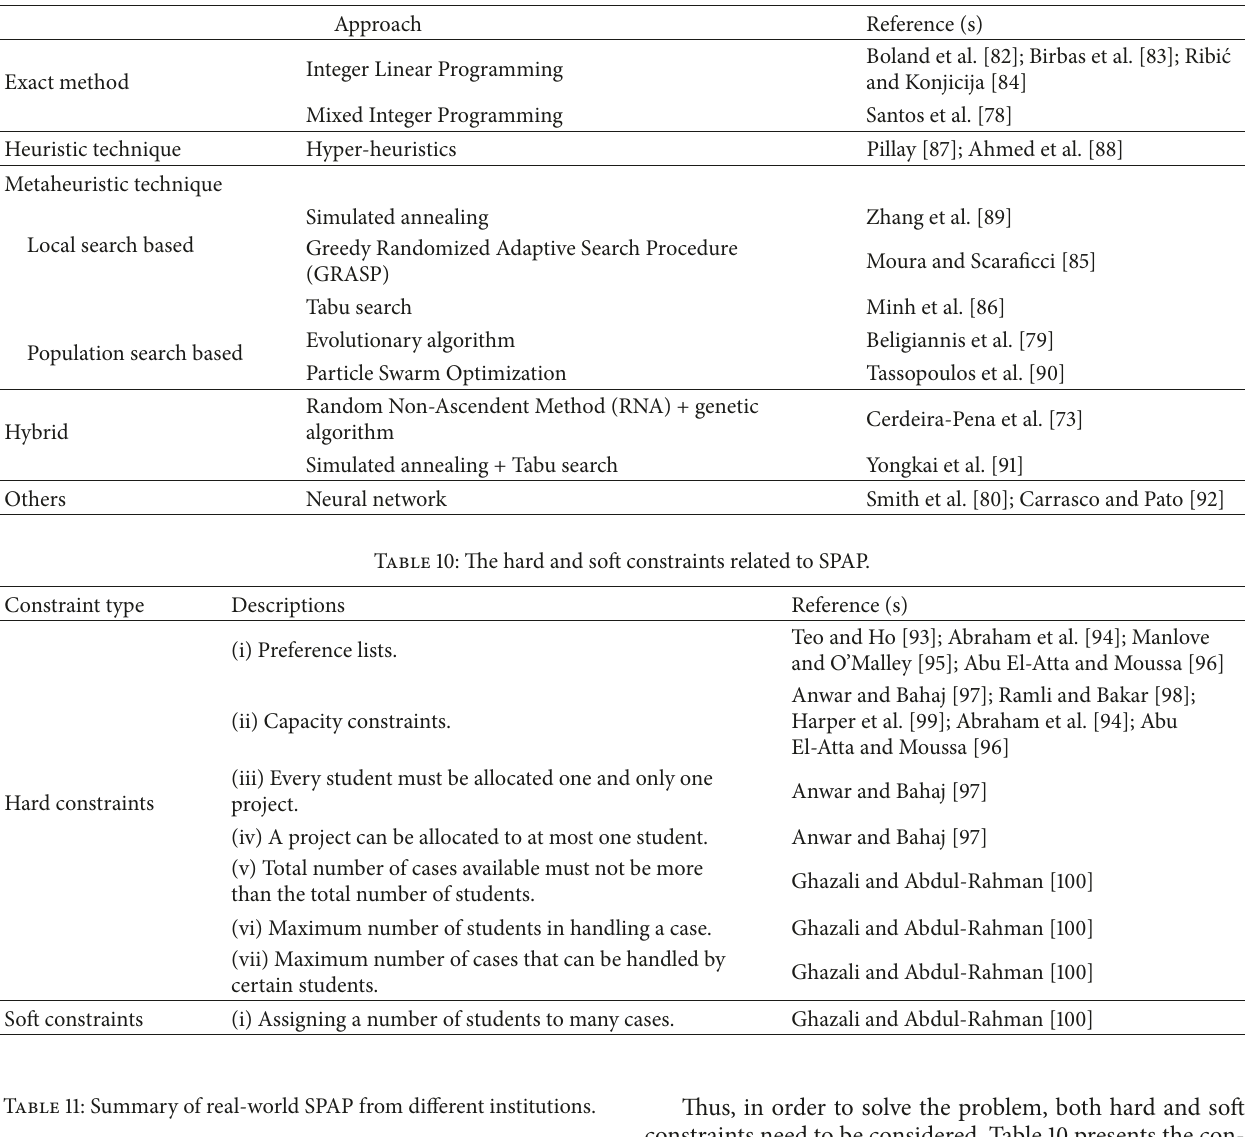
Table 9: Summary of studies related to STP.